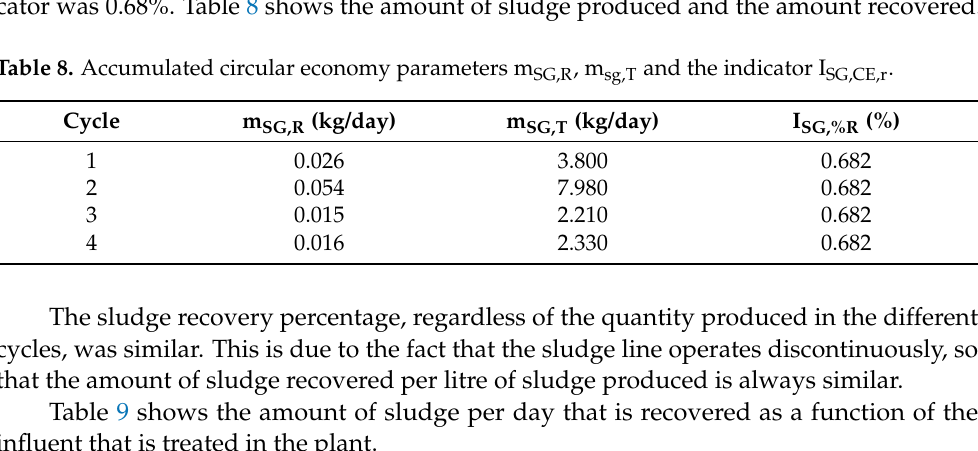
Table 8. Accumulated circular economy parameters m SG,R , m sg,T and the indicator I SG,CE,r . Cycle